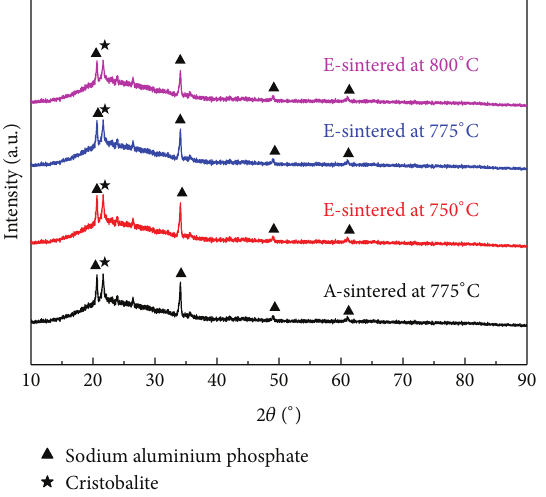
Figure 3: XRD patterns of foam glass samples A and E sintered at 750 ∘ C, 775 ∘ C, and 800 ∘